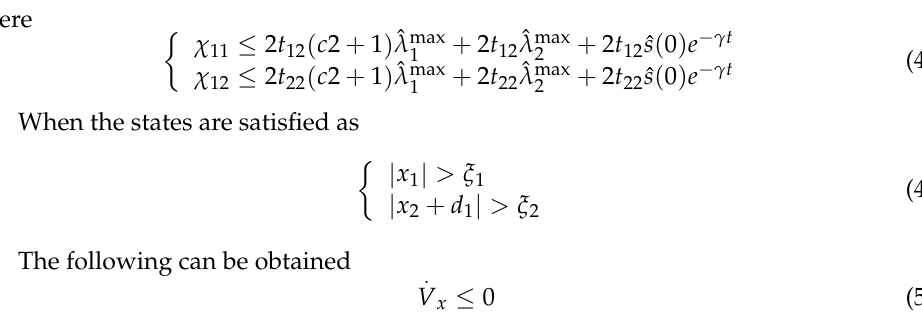
Figure 4. Missile–Target pursuit trajectory by using EDO and SMCBS. ( a )